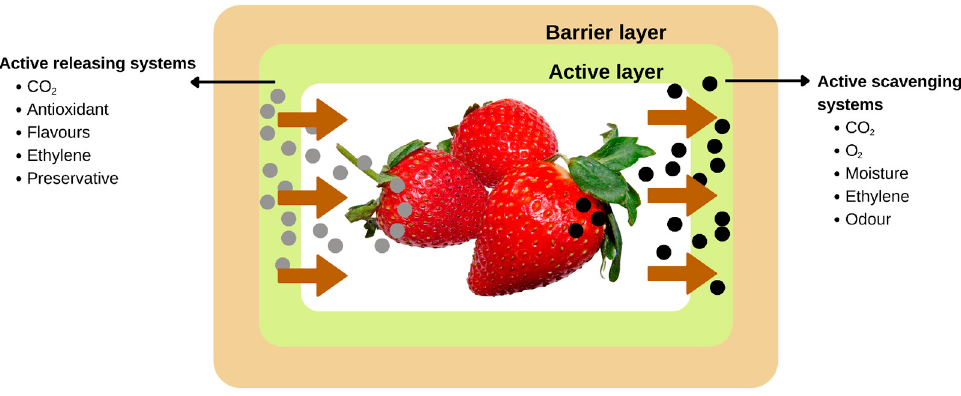
Figure 8. Active packaging as quality control of fruits and vegetables. Table 4. Application of active packaging in food products.